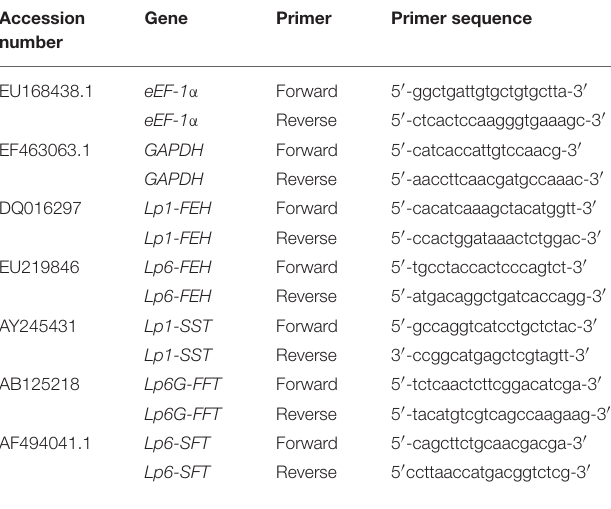
TABLE 1 | Primers used for quantitative RT-PCR analysis of perennial ryegrass